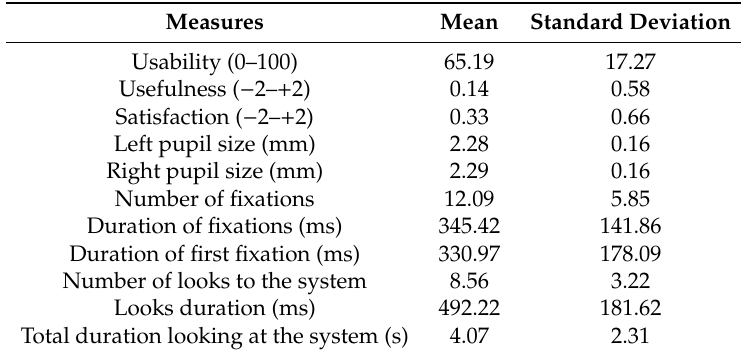
Table 6. Mean and standard error of the mean for variables analyzed under real driving conditions.